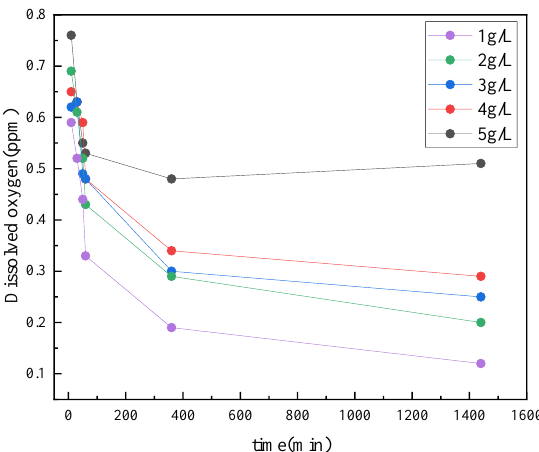
Figure 12. Results of dissolved oxygen in annular protective solution under different concentrations of oxygen absorber.